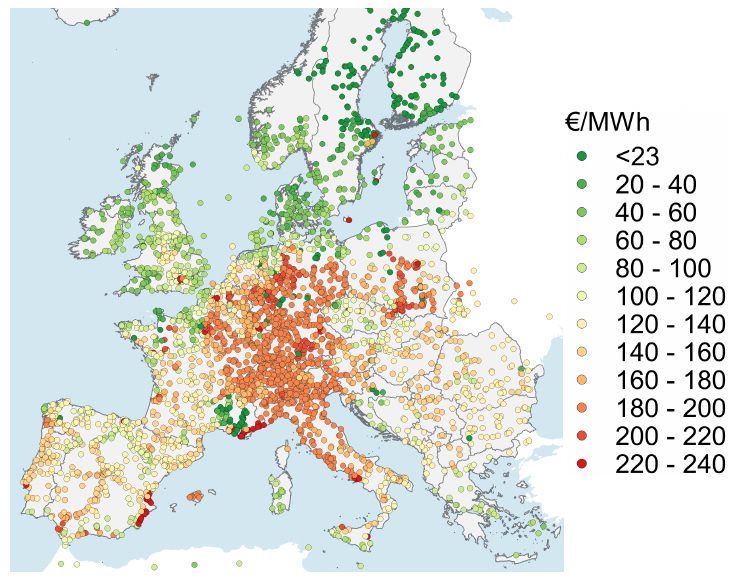
Figure 4. Energy mix per country for the scenario “large-scale RES” in 2050 including total imports and exports.